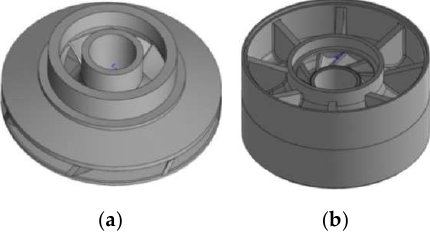
Figure 1. The geometric model. ( a ) Impeller; ( b ) Diffuser.